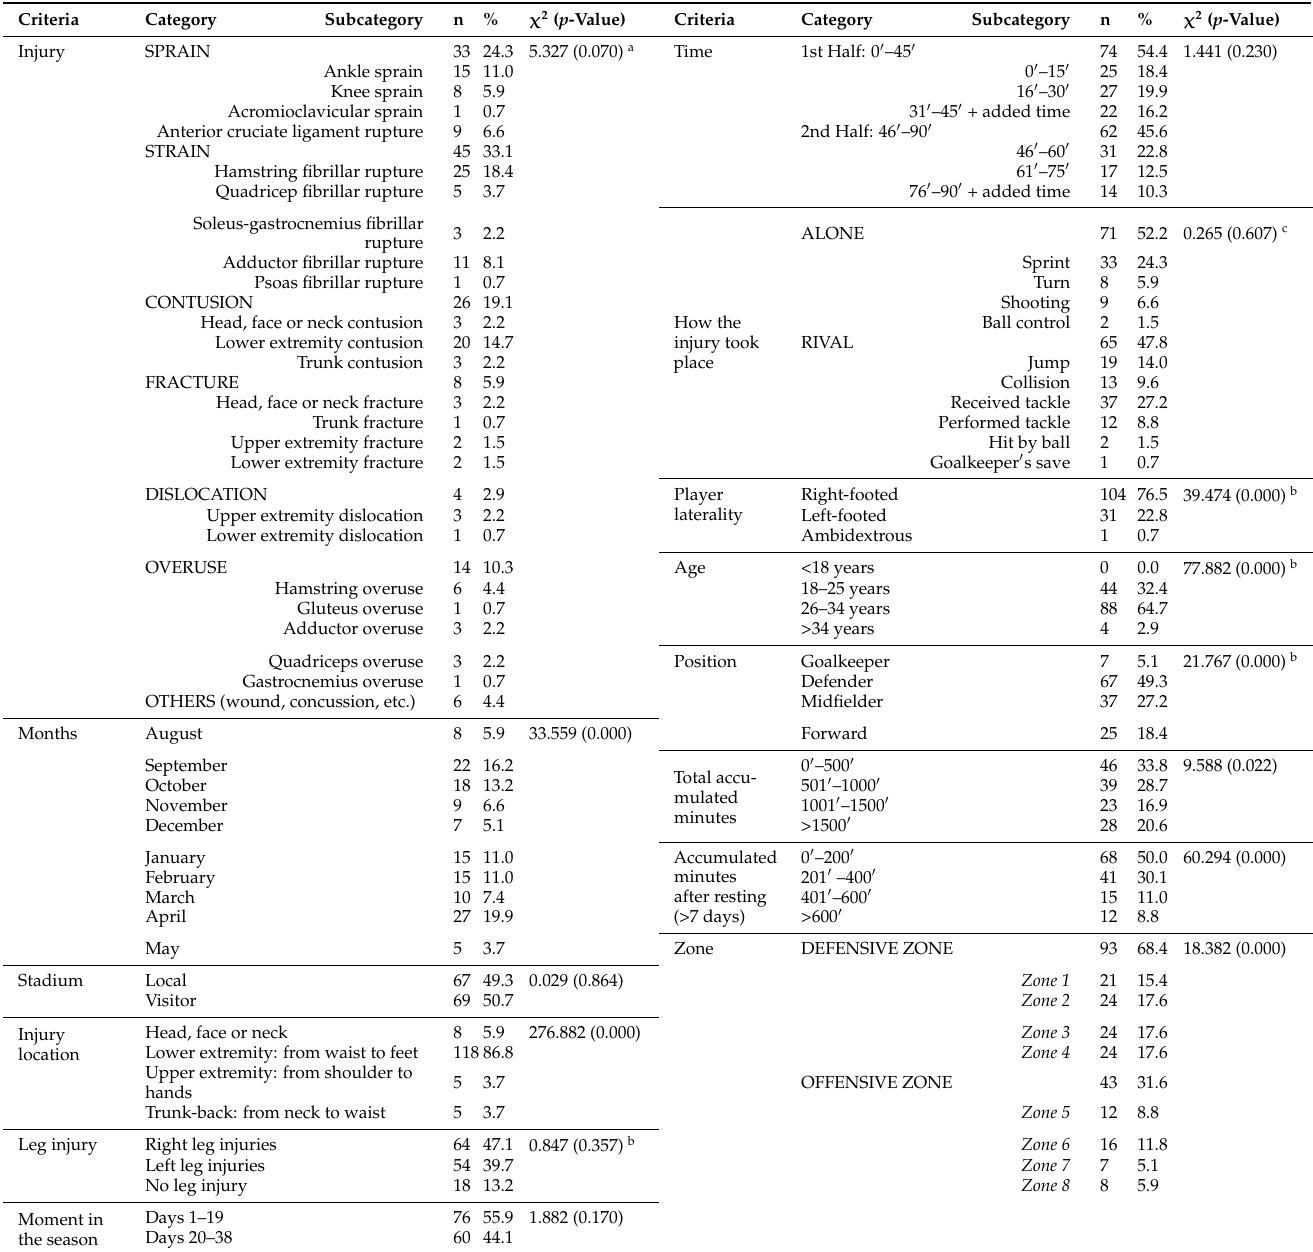
Table 1. Descriptive obtained values and χ 2 test